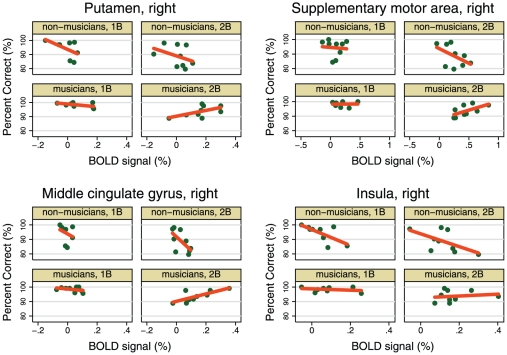
The strength of linear correlation between percent correct responses and the BOLD response differs significantly between musicians and non-musicians in the 2B task.The four regions illustrated are those that individually exhibit a significantly more positive linear slope in musicians than non-musicians in the 2B condition. This tendency, which is also present in the 1B condition, shows that by recruiting more brain resources during a WM task, musicians are able to sustain a higher performance level in face of the elevated cognitive demands. The green dots in each plot are measurements from individual subjects, and the orange line is the corresponding best-fitting regression line. NB: A single model was fit that was flexible enough to allow all four slopes to differ (see Methods for details); no R2-values are therefore given for the individual slopes. See Table 3 for a full account of the results and general tendencies for all regions.